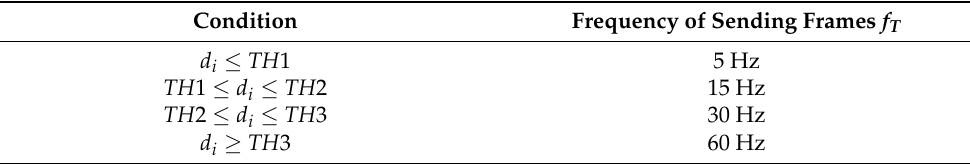
Table 1. Frequency of sending frames depending on the parameter d i